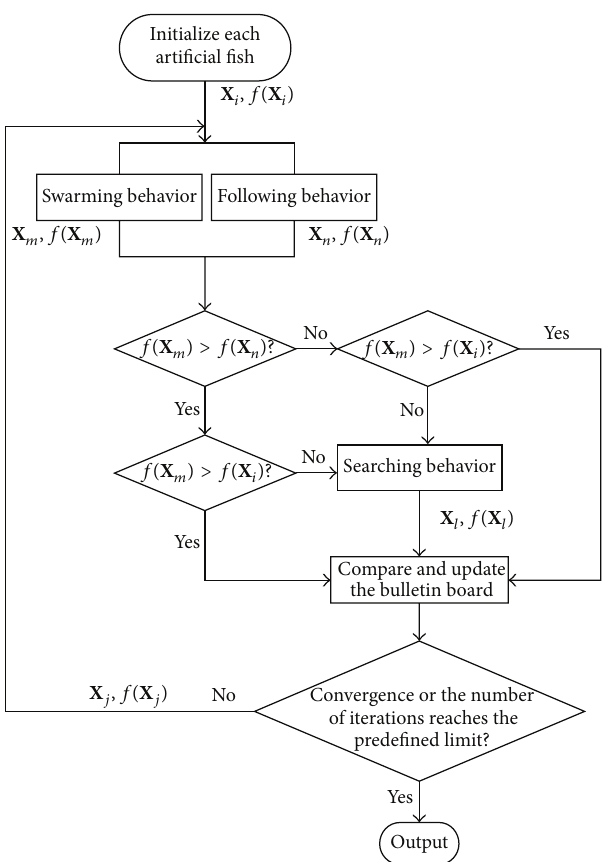
Figure 1: The behavior of each artificial fish in